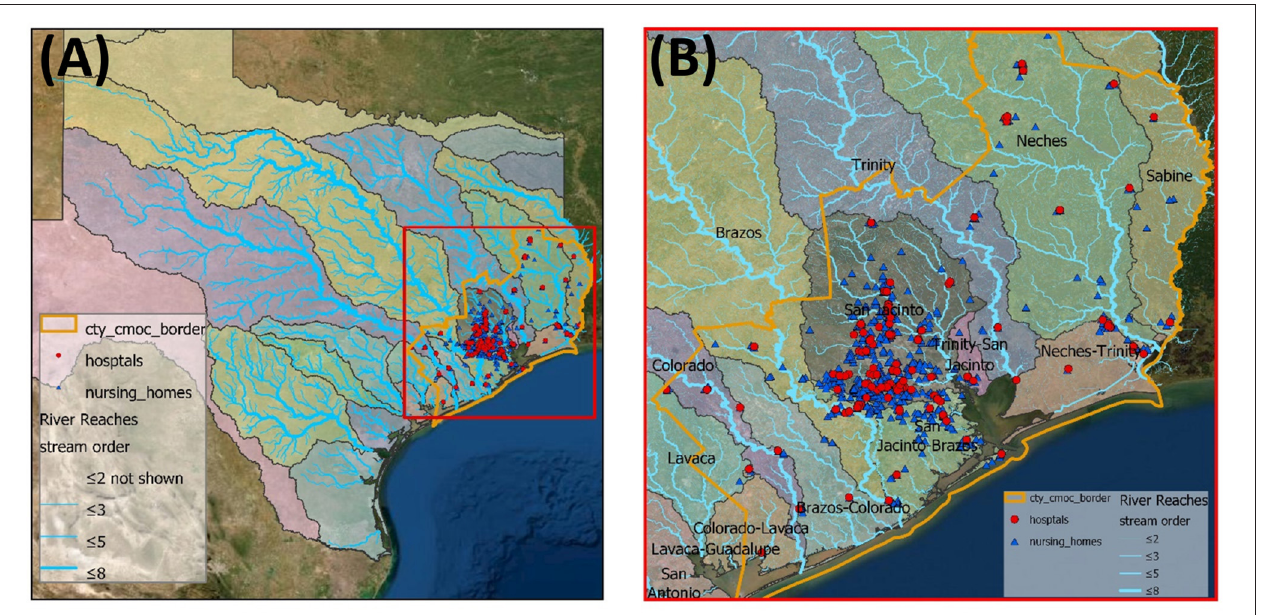
FIGURE 6 | The WRF-Hydro modeling domain within the Texas-Gulf Region. (A) Entire modeling domain that consists NHDPlus reaches, (B) the region of the hospitals and nursing homes